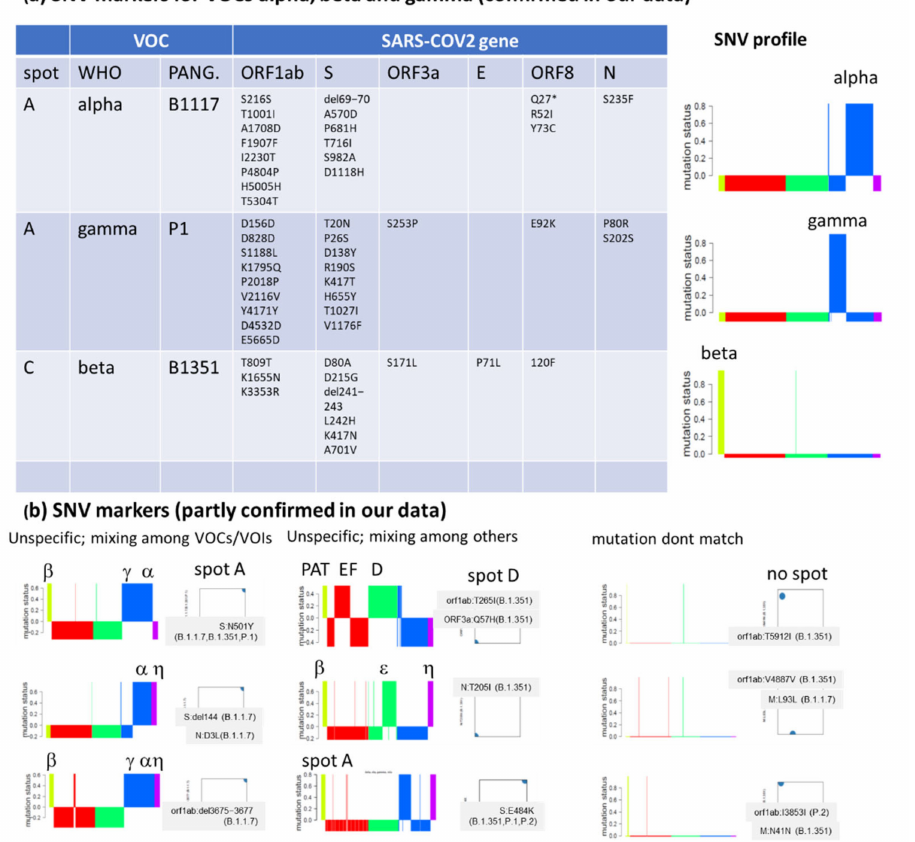
Figure A8. Map of the high-confidence gene set of mutations taken from [39]. ( a ) Most of the SNV are confirmed in our data as specific for the intended VOC. The respective SNV profiles show mutational load in respective variants. ( b ) A small fraction of suggested SNVs are not confirmed in our data showing mutations in more than one VOC/VOI, in different PATs or even lack marked mutational